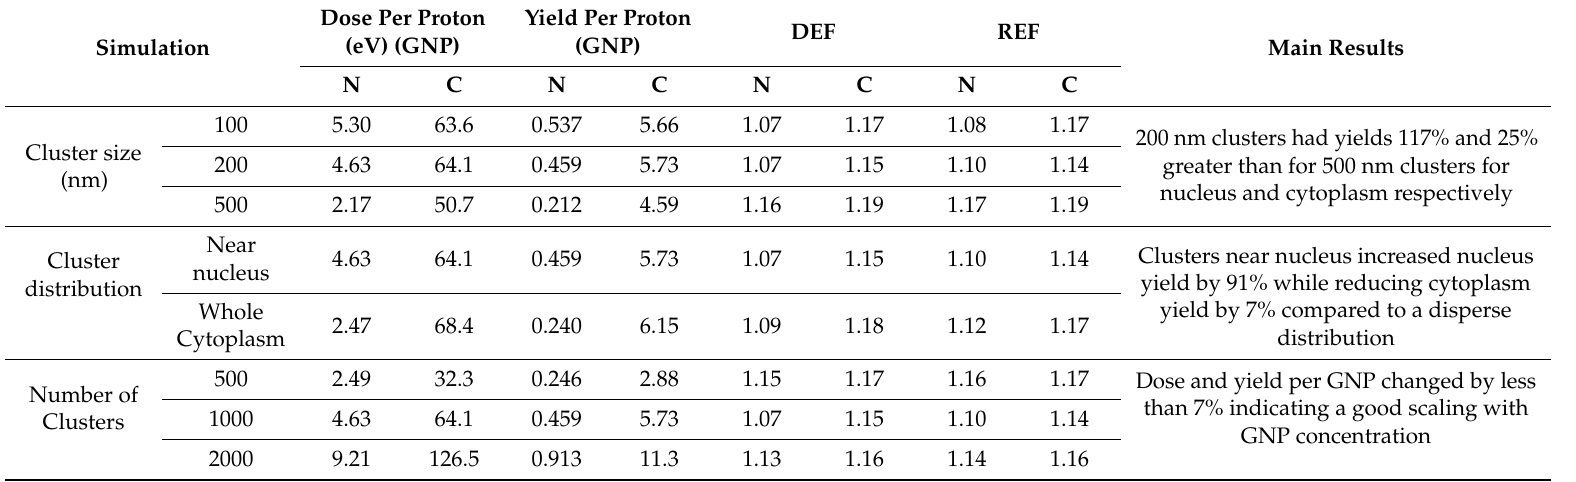
Table 1. The dose, radiolysis yield at 1 µ s, dose enhancement factor (DEF) and radiolysis enhancement factor (REF) at 1 µ s within the nucleus (N) and cytoplasm (C) for GNP cellular distribution simulations. Key results are also